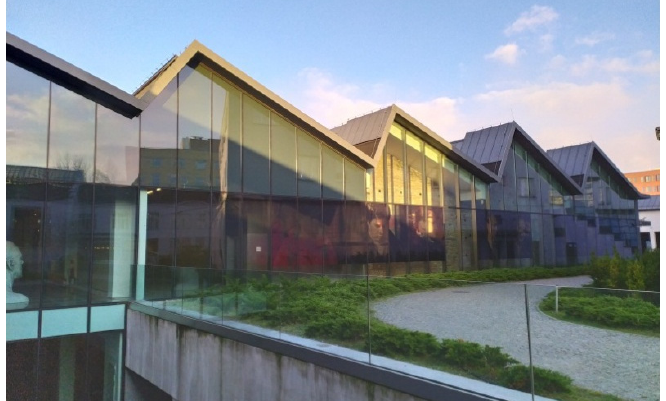
Figure 13. Museum of Contemporary Art in Kraków-MOCAK, designed by Claudio Nardi Architette